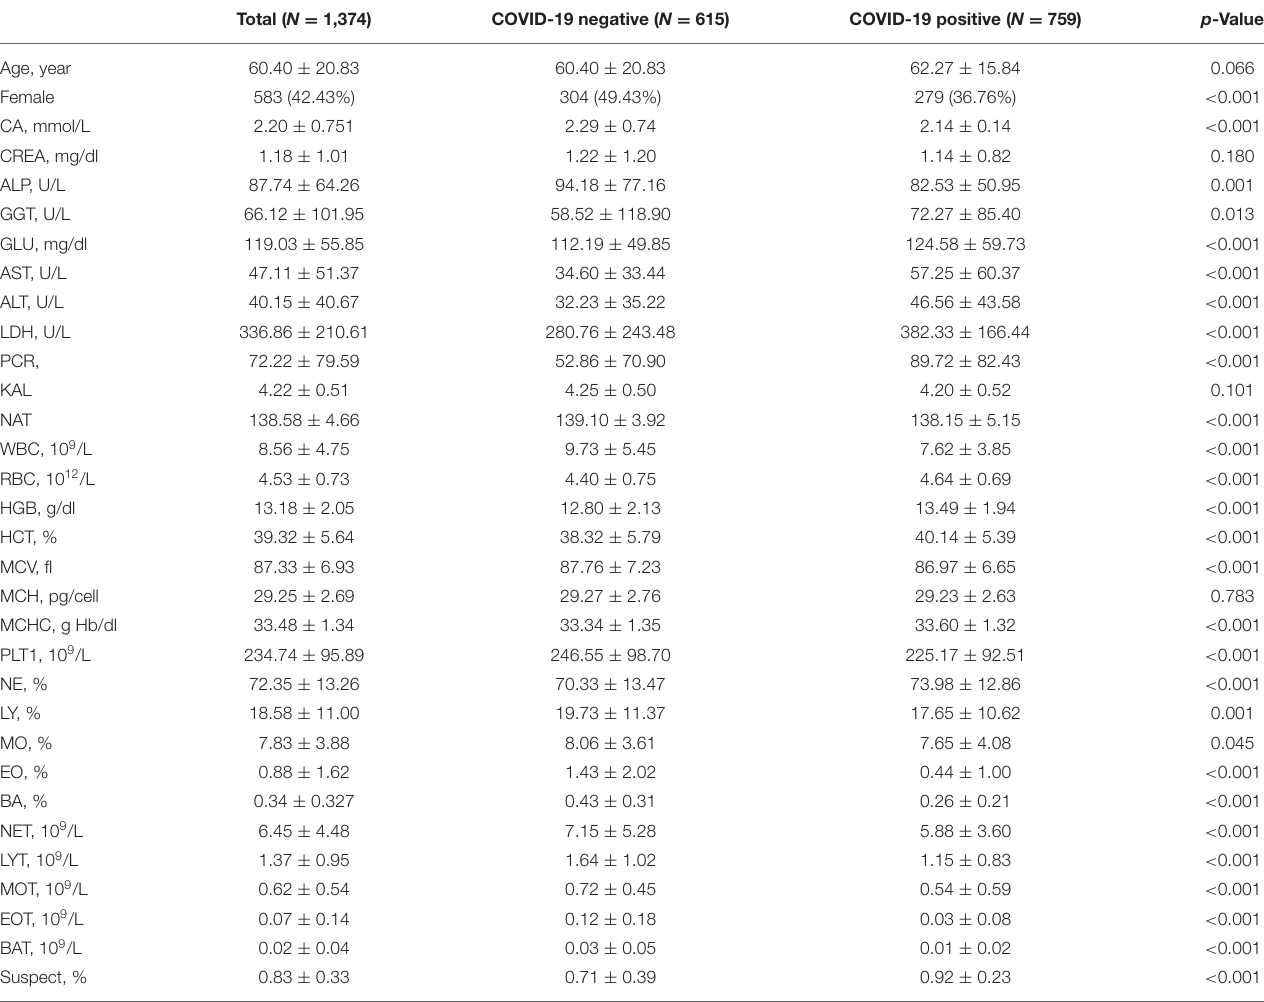
TABLE 2 | Characteristics of the positive and negative COVID-19